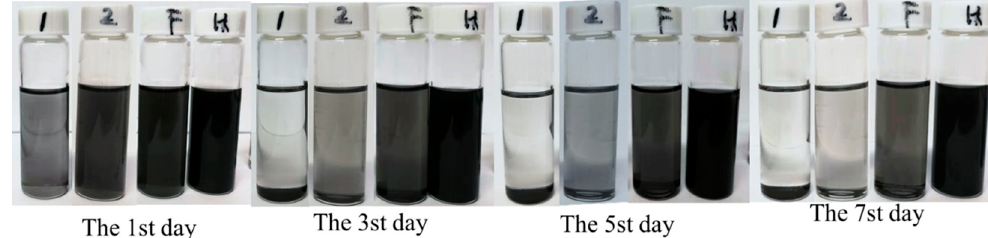
Figure 6. Image of the prepared powders in N-Methyl pyrrolidone (NMP) with the concentration of 0.1 mg / mL: the products were only obtained by ball milling without Fe 3 O 4 nanoparticles (OBPs, Marked by the number 1), the products were obtained by the two-step method without Fe 3 O 4 nanoparticles (BHPs, Marked by the number 2), the BFPs (marked by the letter F) and the FLG (marked by the letter H).